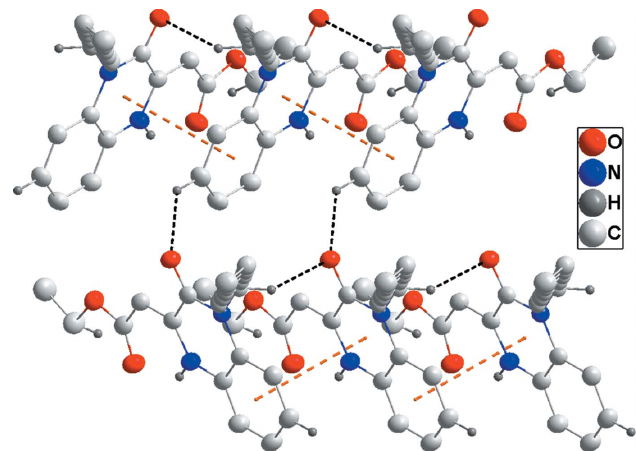
Figure 2 Side view of two stacks projected onto (501), with the b -axis direction running from left to right. C—H (cid:2)(cid:2)(cid:2) O hydrogen bonds are shown as black dashed lines, while orange dashed lines show the (cid:2) -stacking